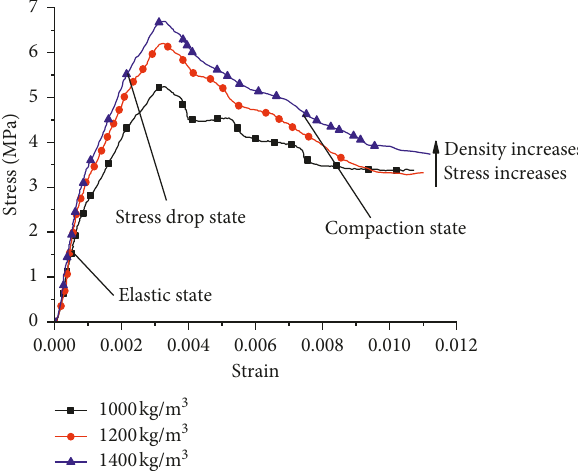
Figure 21: Quasistatic stress-strain curves of the foam concrete with fly